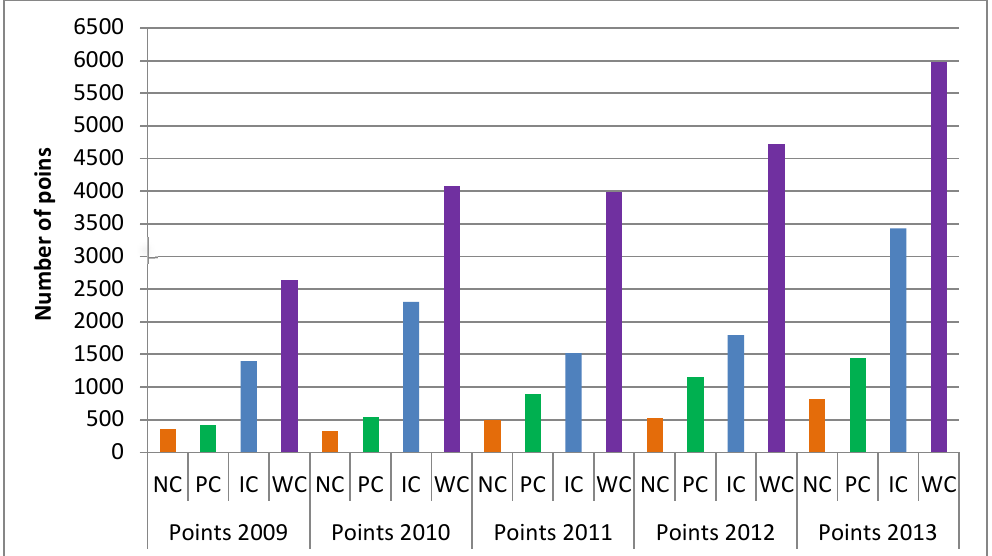
Figure 2. Competition success (CS) as total achieved points from scores and standings from all age competition categories from years 2009 to 2013 for different categorisation classes. NC—National class, PC—Perspective class, IC—International Class, WC—World class.